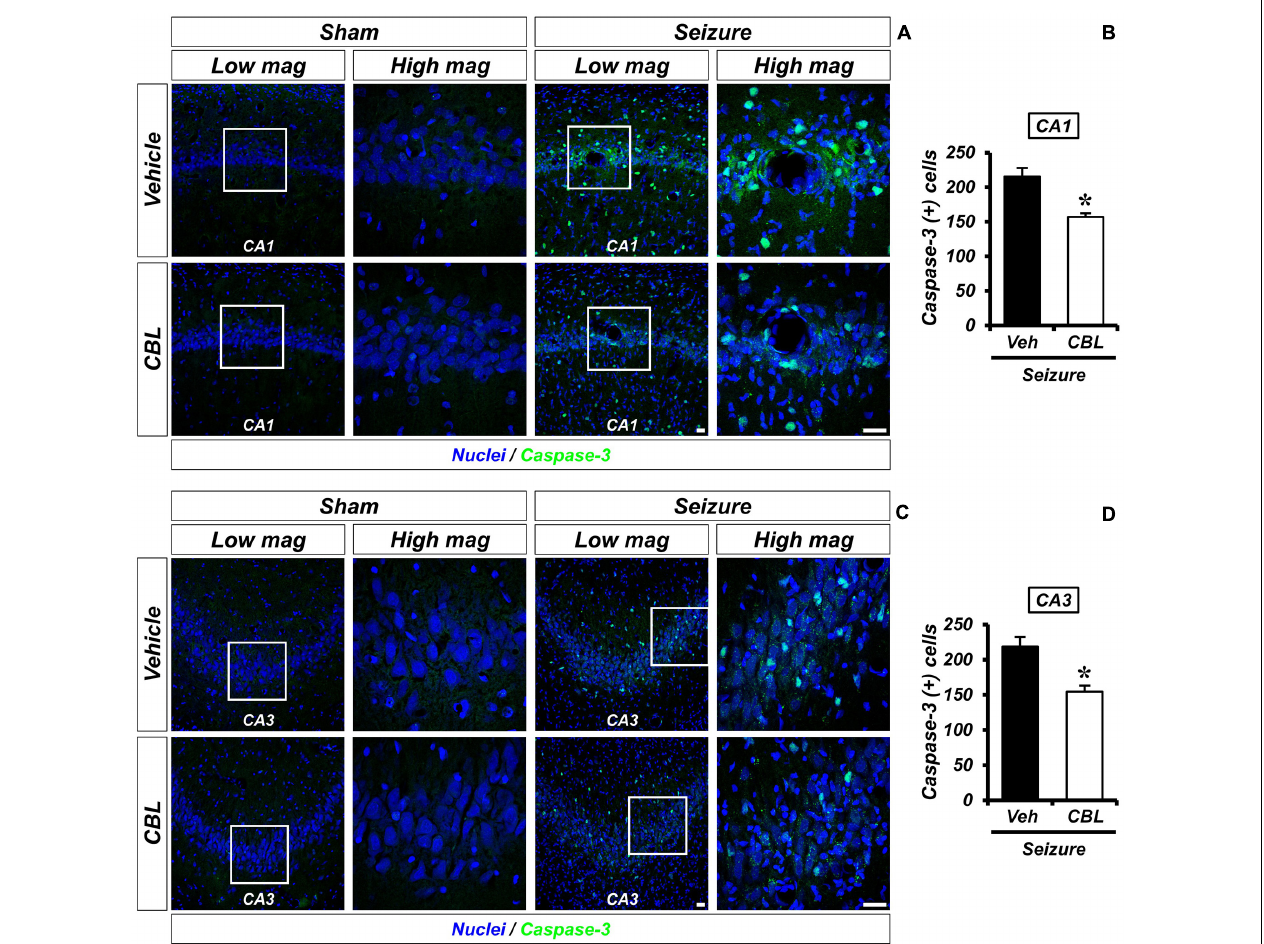
FIGURE 5 | Cerebrolysin decreases the number of apoptotic cells after pilocarpine-induced seizure. The administration of cerebrolysin decreases apoptosis after pilocarpine-induced seizure. (A,C) Cleaved caspase-3 (green) in the hippocampal CA1 and CA3 regions. After a seizure, the administration of cerebrolysin for 1 week decreased the number of apoptotic cells in the hippocampal CA1 and CA3 regions compared to the seizure-vehicle groups. Scale bar = 20 µ m. (B,D) A graph that shows the number of apoptotic cells. The data are the mean ± SEM, n = 5–7 for each seizure group. * p < 0.05 [Mann–Whitney U -test: (B) z = 2.842, p = 0.03, (D) z = 2.517, p =